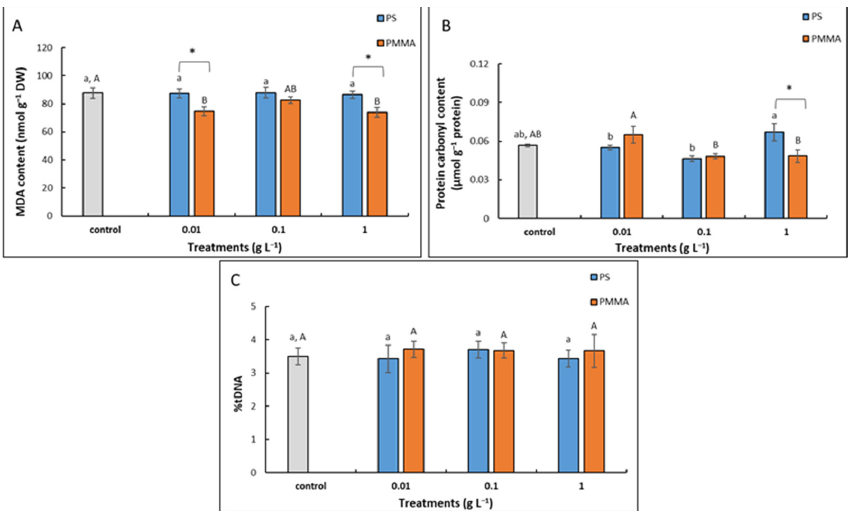
Figure 6. Content of malondialdehyde (MDA) ( A ), protein carbonyls ( B ), and %tDNA ( C ) in A. cepa control roots and after 72 h treatment with 0.01, 0.1, and 1 g L − 1 of PS-MPs and PMMA-MPs. Values are means ± standard errors of two different experiments, each with 6 replicas ( n = 12). If columns are marked with different letters or asterisk, the treatments are significantly different at p ≤ 0.05 (one-way ANOVA followed by Duncan post hoc test); small letters mark the differences among different concentrations of PS-MPs and control, capital letters mark the differences among different concentrations of PMMA-MPs and control, and asterisk (*) denotes difference between the same concentration of different MP types.